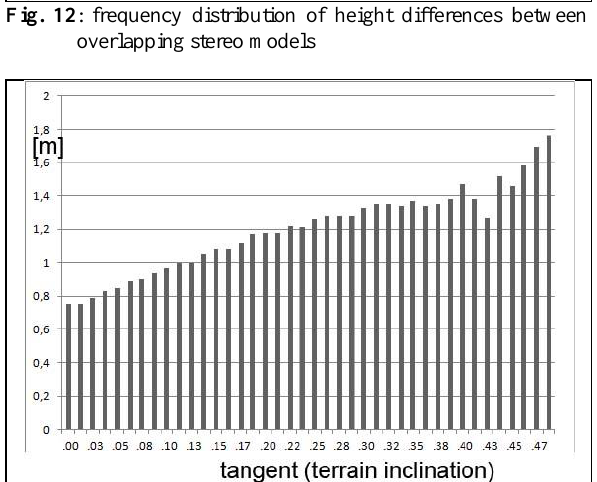
Fig. 13 : root mean square height discrepancies depending upon terrain